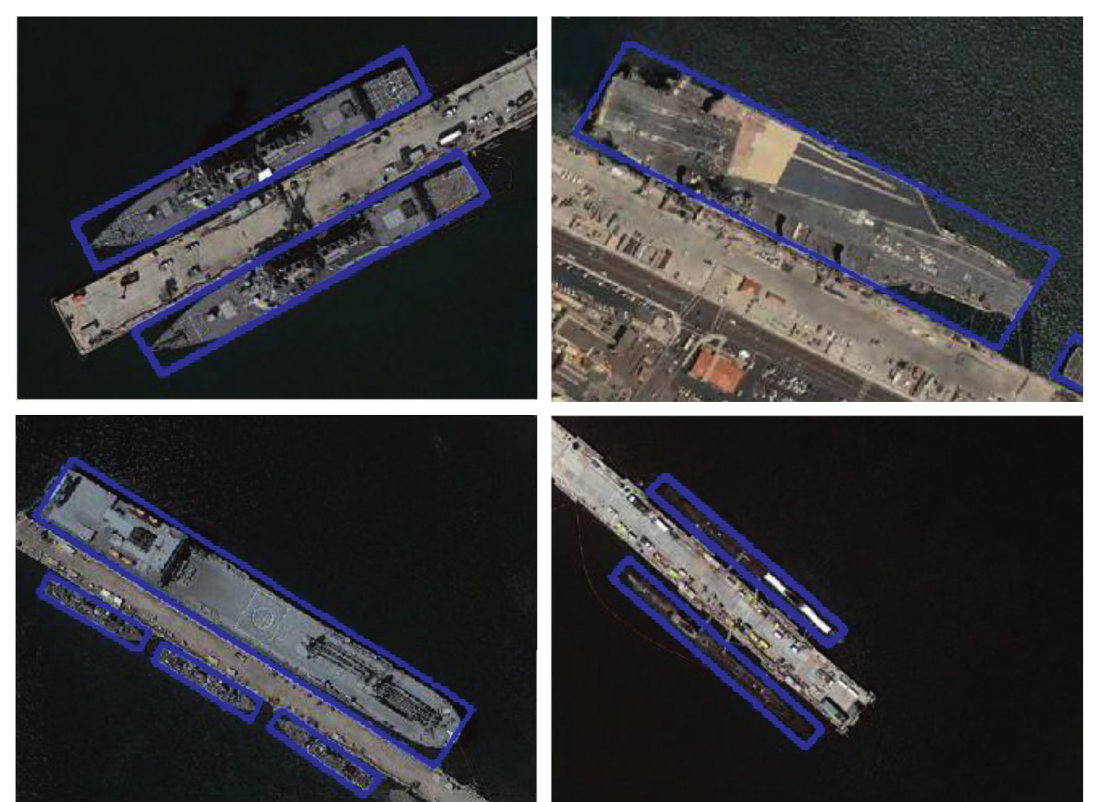
Figure 7: DOTA dataset